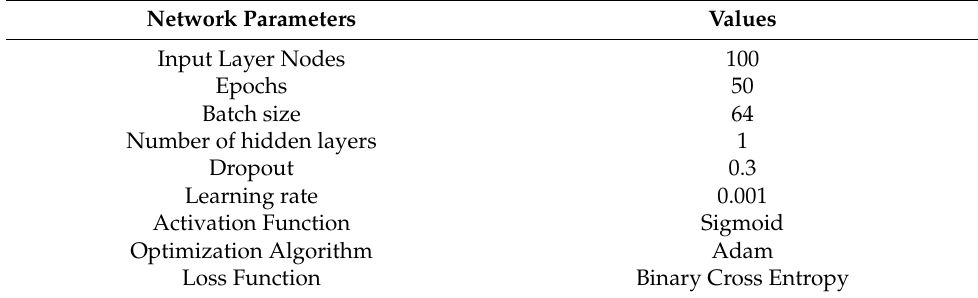
Table 1. General parameters of LSTM